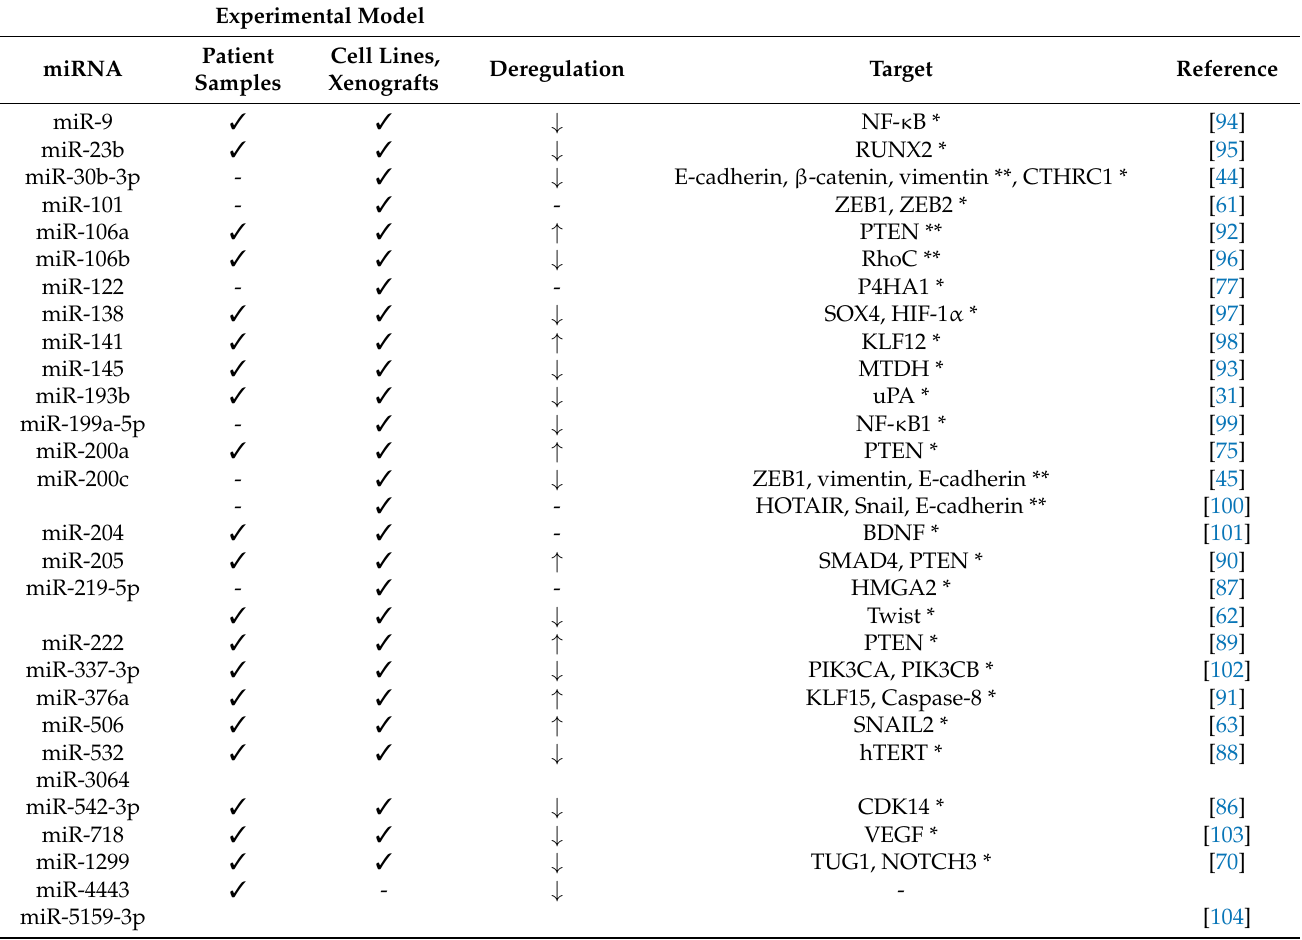
Table 1. miRNAs and their implication in ovarian cancer